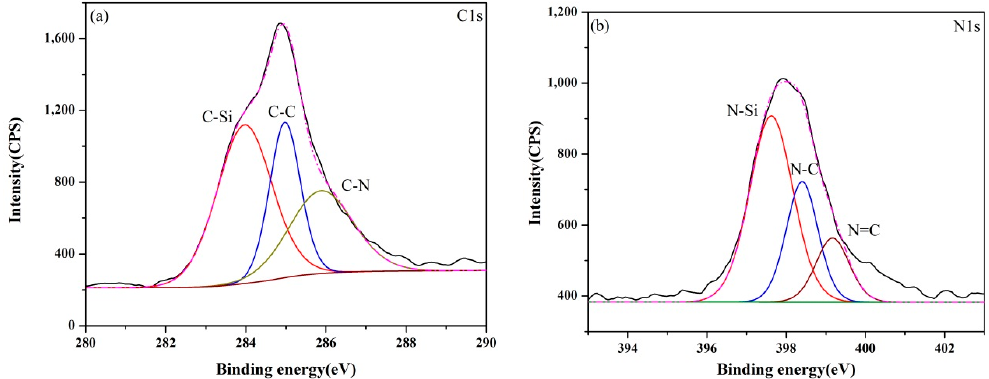
Figure 7. XPS core-level spectra of sample B synthesized at 1550 °C: ( a ) C1s, ( b ) N1s and ( c ) Si2p.